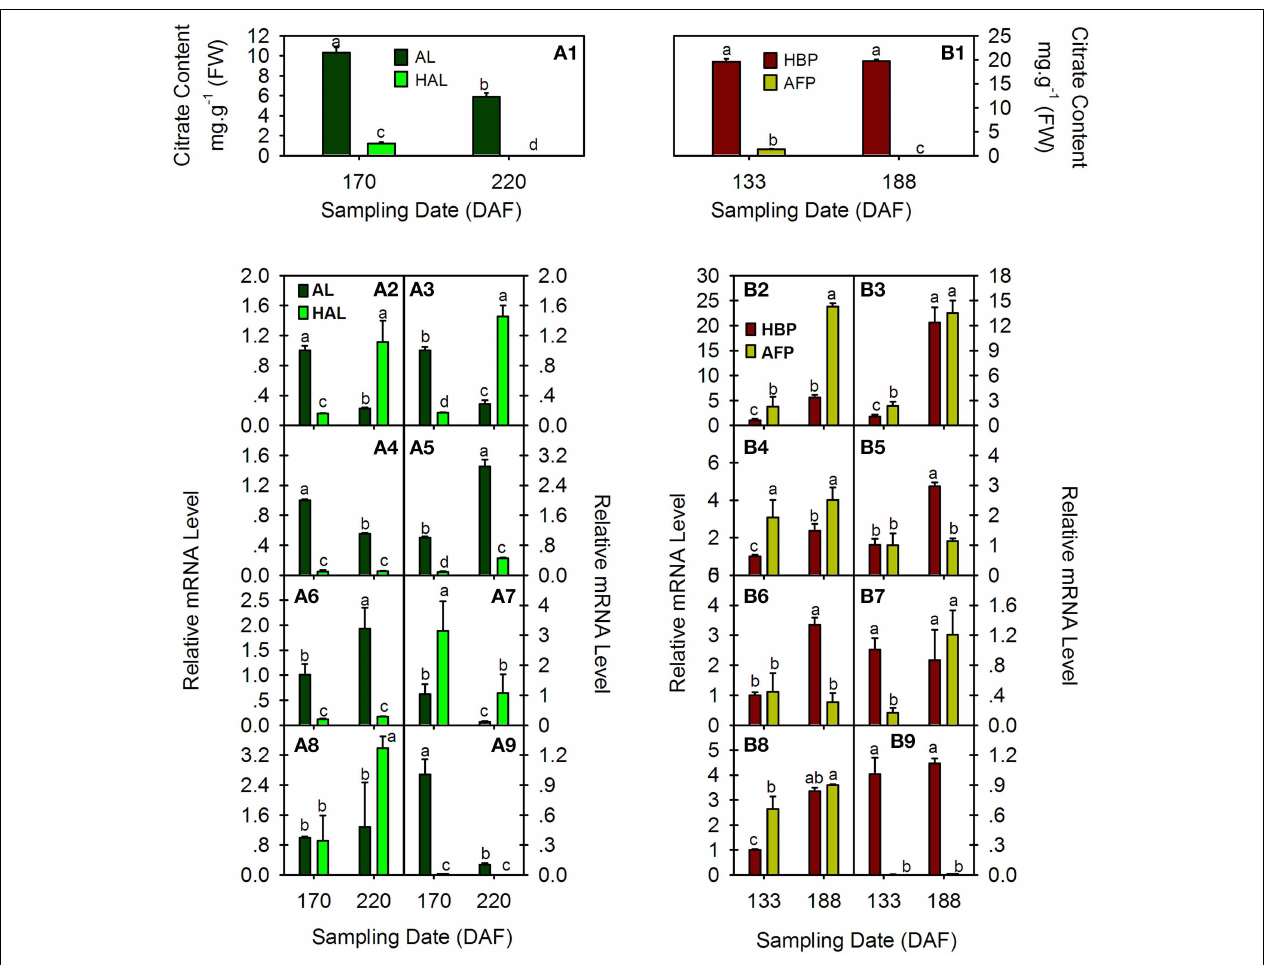
FIGURE 5 | Comparative analysis of citrate concentration (A1 and B1) and relative transcript levels of eight CsPH genes in fruit juice sacs from Anliu orange (AL), Honganliu orange (HAL), HB pummelo (HBP), and acid-free pummelo (AFP) at two developmental stages.